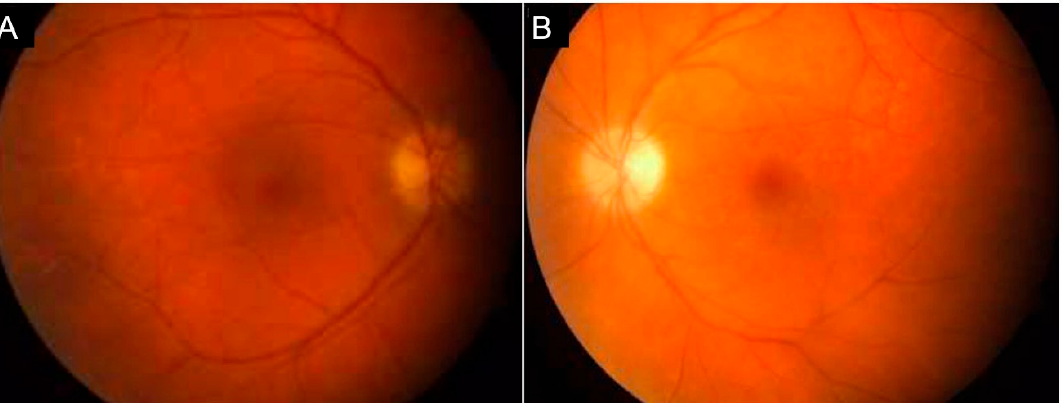
Figure 14. Initial presentation of a 43-year-old female patient with birdshot chorioretinopathy. Fundus photography of the right ( A ) and left eyes ( B ) showing discrete yellowish ovoid choroidal lesions in the peripapillary and midperiphery area.